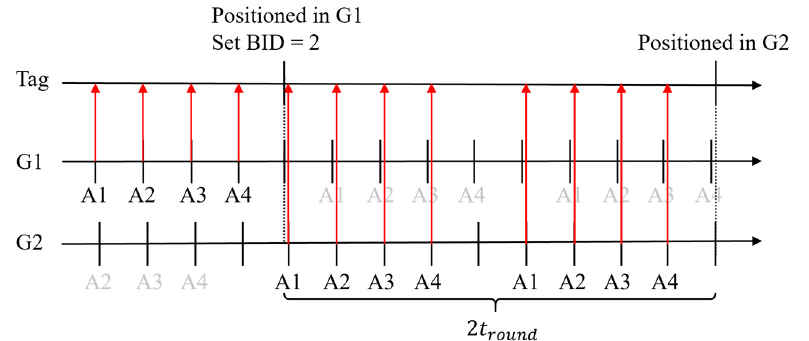
Figure 18. The best case for the switching group.